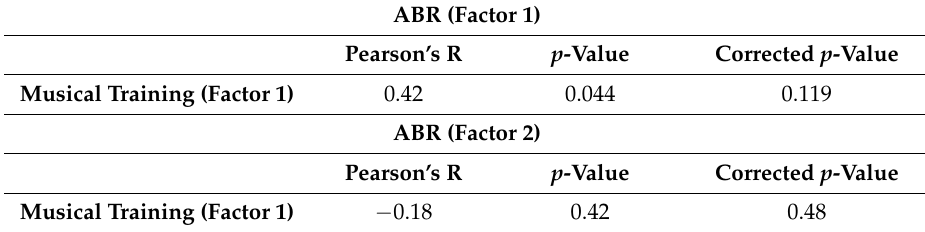
Table 11. Relations between Musical Training History and Sensorineural Auditory Processing. Pearson’s R computed between musical training and auditory brainstem response (ABR) factors. Here, musical training factor 1 reflected a global measure of musical experience. ABR factor 1 predominately reflected neural condition times (e.g., inter-peak latencies of the ABR waves I to III and wave I to V), while ABR factor 2 largely reflected neural response consistency. The correlations are presented with corrected probability values using the Benjamini & Hochberg (BH) correction to control the false discovery rate